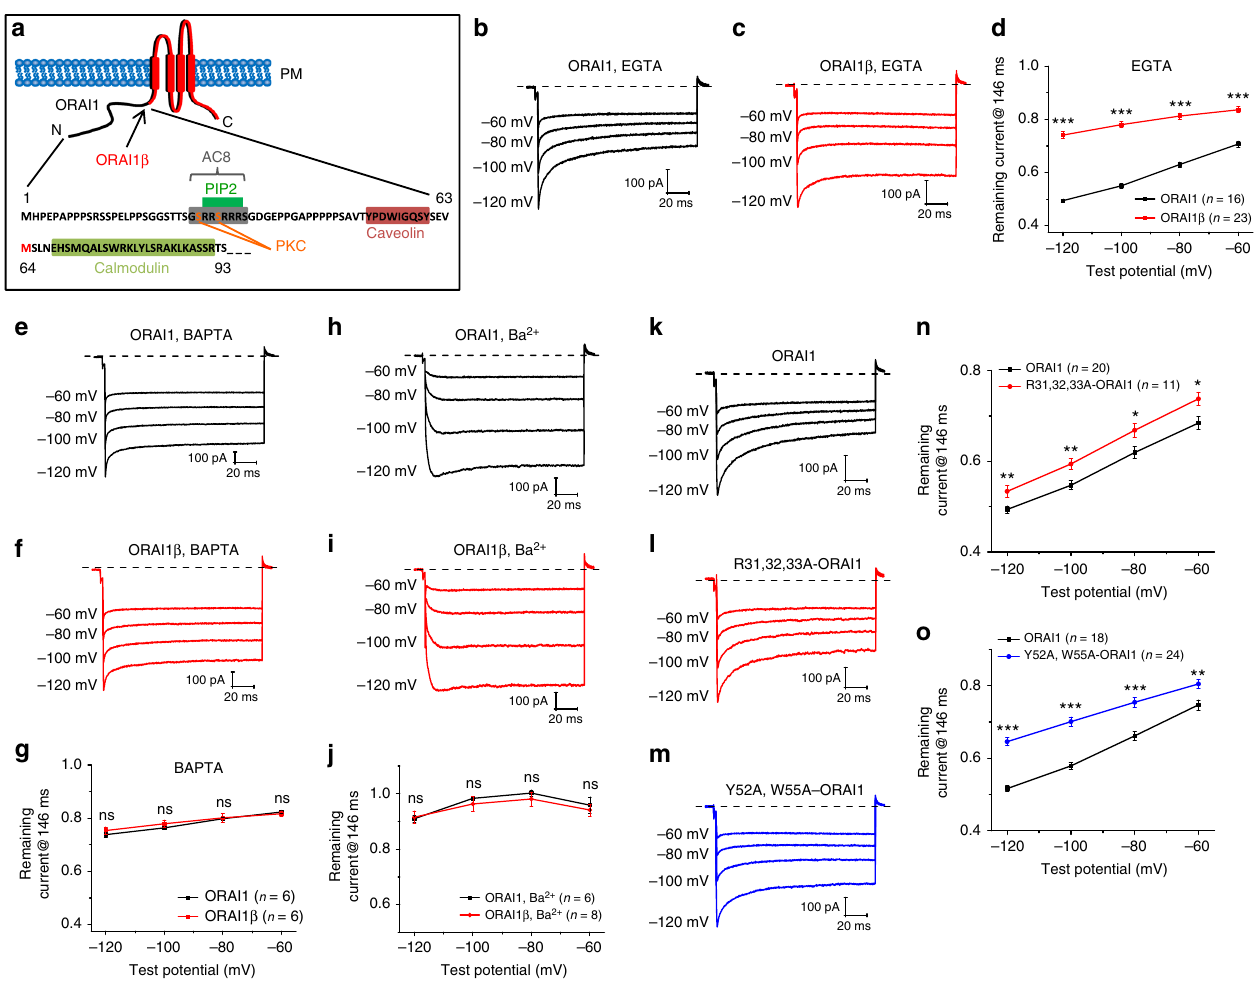
Fig. 1 AC8- and cav-binding site on ORAI1 are required for ORAI1 CDI. a Schematic of consensus domains unique to ORAI1. The fi rst N-terminal 63 amino acids are exclusive to ORAI1 (black). ORAI1 β (red) starts at Methionine-64. The putative calmodulin (CaM)-binding domain is found in both ORAI1 and ORAI1 β . Recordings are from ORAI-KO cells co-expressing eYFP-STIM1 with either ( b , e , h ) ORAI1-CFP or ( c , f , i ) ORAI1 β -CFP. Representative currents using either 10 mM EGTA ( b , c ), or 20 mM BAPTA ( e , f ) in patch pipette with 20 mM Ca 2 + bath solution, or 10 mM EGTA in patch pipette with 20 mM Ba 2 + bath solution ( h , i ). CDI was revealed by applying a voltage-step protocol from a holding potential of + 30 mV as depicted in (Supplementary Fig. 1f; see Methods). d , g , j The extent of CRAC channel inactivation for ORAI1 and ORAI1 β represented as current remaining at the end of the pulse (at 146 ms; see Methods). Each data point represents mean ± SEM. k – o Representative currents from ORAI-KO cells co-expressing eYFP-STIM1 with either k WT ORAI1-CFP, l ORAI1-CFP mutant de fi cient in AC8-binding (R31 – 33A), or m ORAI1-CFP mutant de fi cient in caveolin binding (Y52A, W55A). The extent of CDI for ORAI1 R31 – 33A ( n ) and ORAI1 Y52A, W55A ( o ) compared with the respective side-by-side recordings from WT ORAI1 are represented as mean